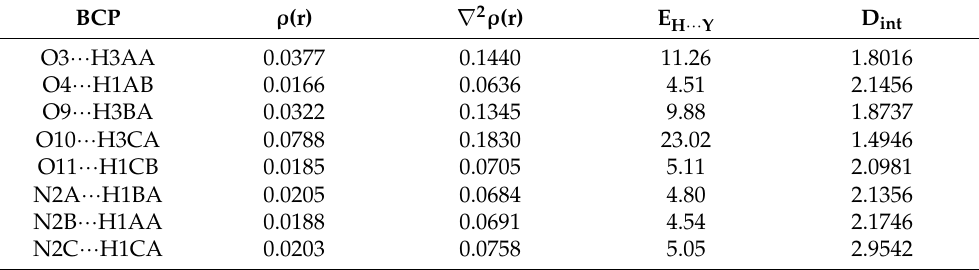
distances D int (in